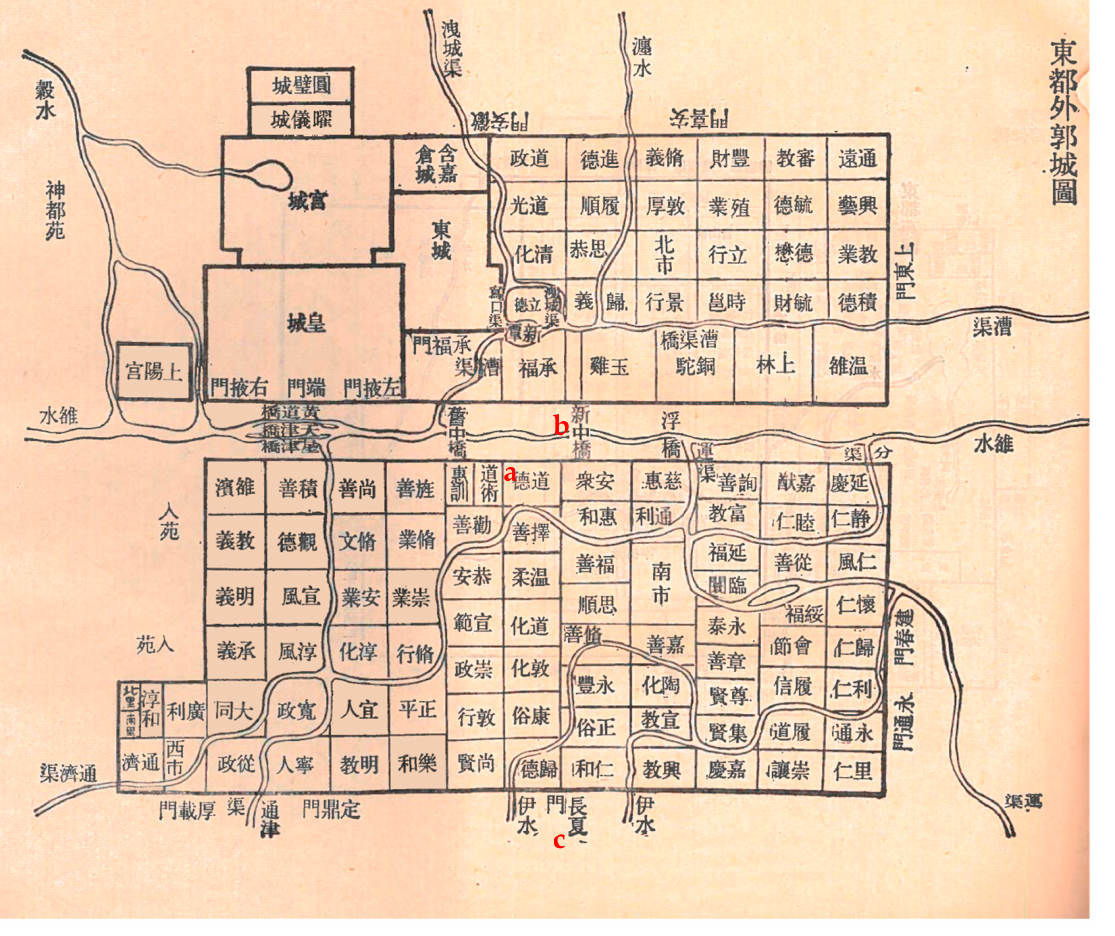
Figure 5. Historical map of the outer city of Luoyang, with red marks of ( a ) Daode (Morality) Ward, ( b ) New Middle Bridge, and ( c ) Changxia (Long Summer) Gate. Image adapted from Xu Song, Tang Liangjing chengfang kao (Beijing: Zhonghua shuju, 1985), front matter. Public